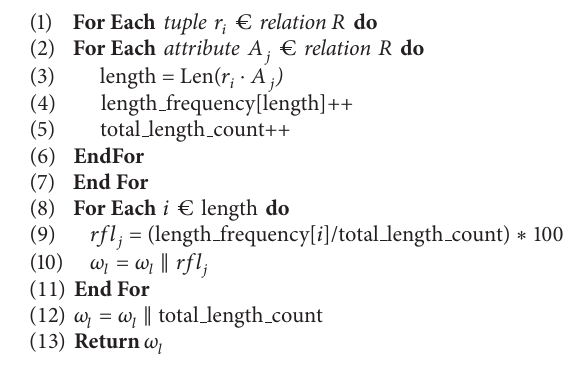
Algorithm 3: Length sub-watermark